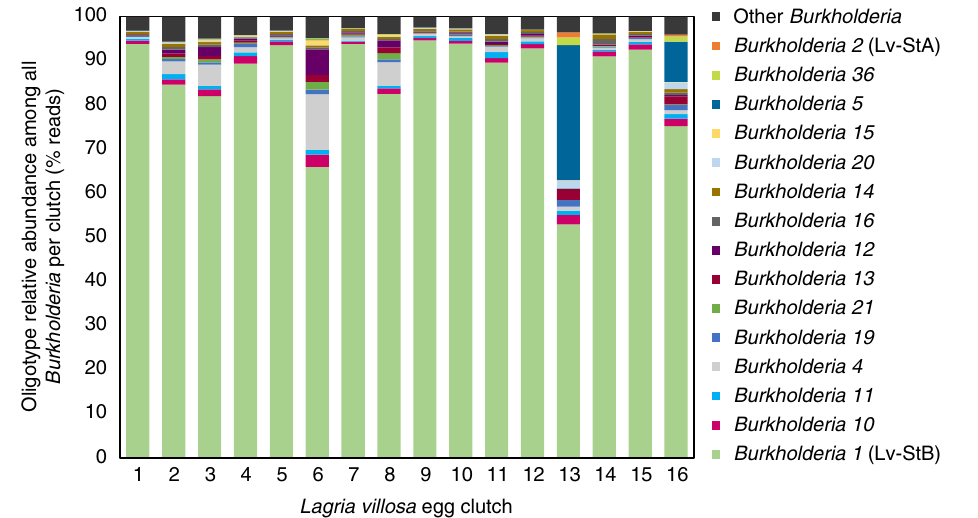
Fig. 1 Burkholderia strain composition on Lagria villosa eggs. Relative abundance of Burkholderia strains in 16 L. villosa egg clutches laid by fi eld-collected females assessed by oligotyping analysis on a 295 bp fragment of the 16S rRNA gene (3467 to 13,677 reads per sample). The assumed correspondence to strains B. gladioli Lv-StB and Lv-StA is indicated in parentheses next to the oligotype identi fi